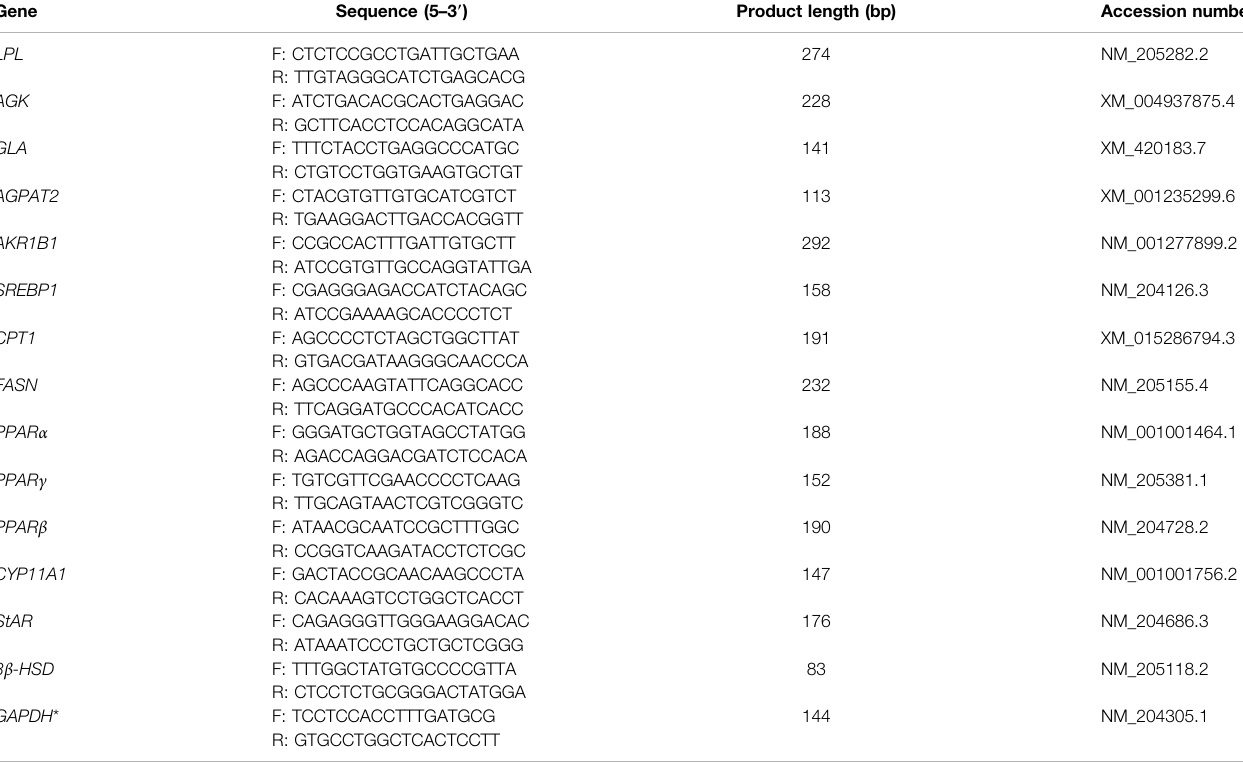
TABLE 2 | Primers used for